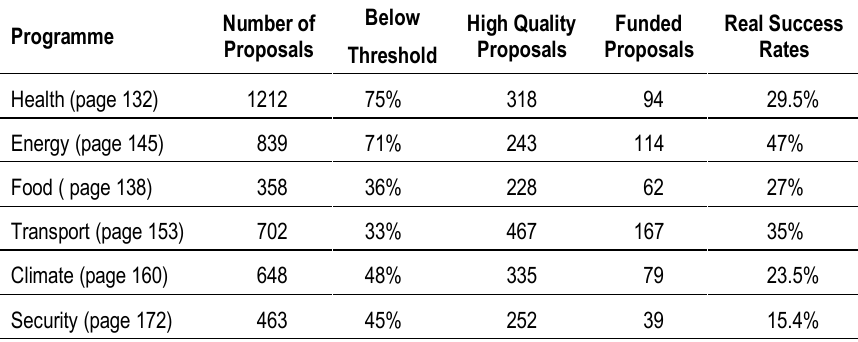
Table 1. Summary of Real Success Rates in the individual programmes in 2015 (SME Instrument Proposals are excluded from the different